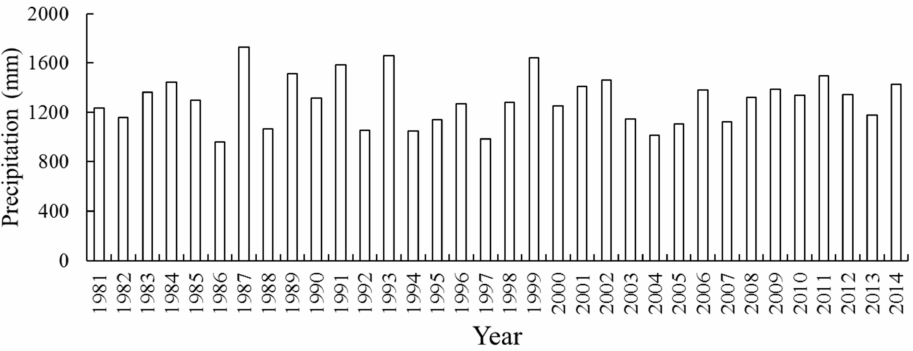
Figure 6. Annual precipitation in Yixing City from 1980 to 2014.